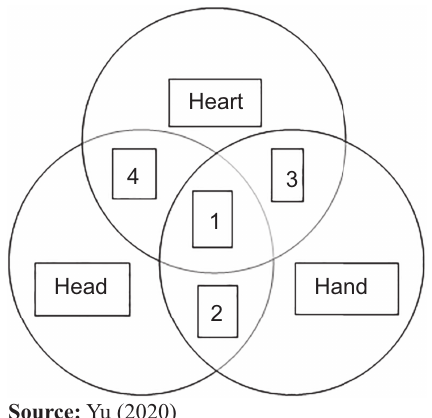
Figure 5. The necessary